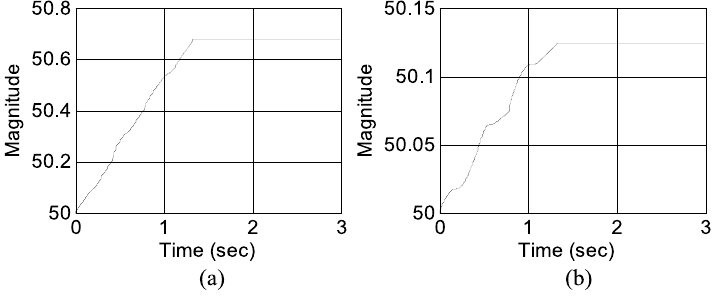
Fig. 5. (a) The adaptation parameter ˆ c 0 ( t ) (b) The adaptation parameter ˆ c 1 ( t )